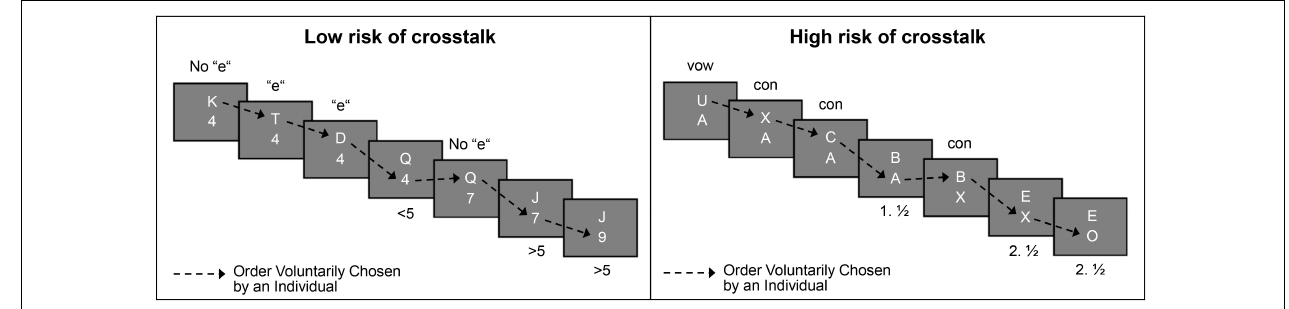
FIGURE 2 | Schematic of the free concurrent dual-tasking (FCDT) paradigm. The figure shows an exemplary trial sequence of a voluntarily chosen task order. The left panel shows the condition of low risk of crosstalk with the corresponding letter (spoken “e” vs. no “e”) and digit task ( < / > 5). The right panel depicts the condition of high risk of crosstalk with the corresponding two letter tasks (vowel vs. consonants; first vs. second half of